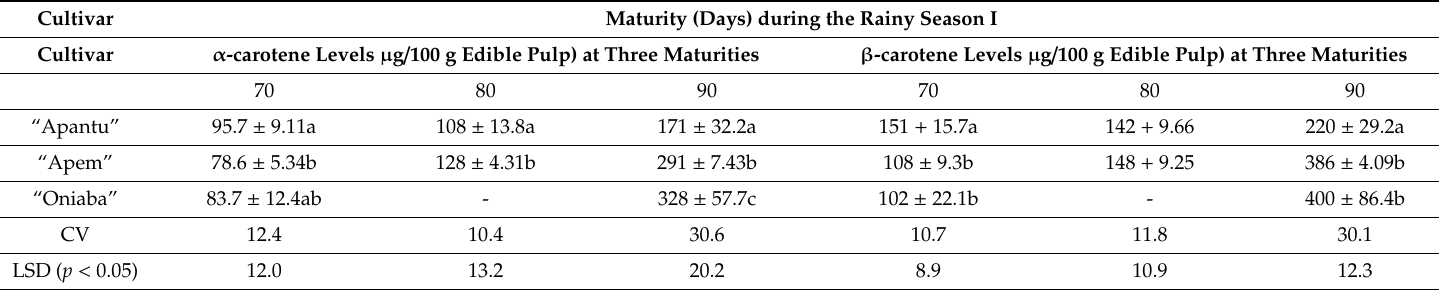
Table 2. Provitamin A active carotenoid contents of three di ff erent plantain cultivars at maturation and seasonality. Cultivar